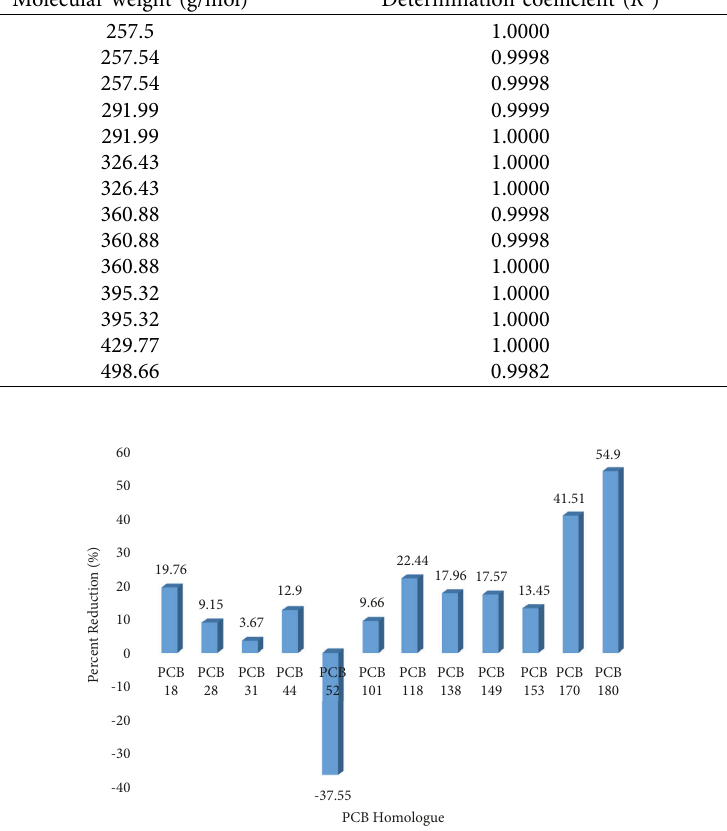
Figure 7: Percent Reductions in PCBs by the charcoal filter